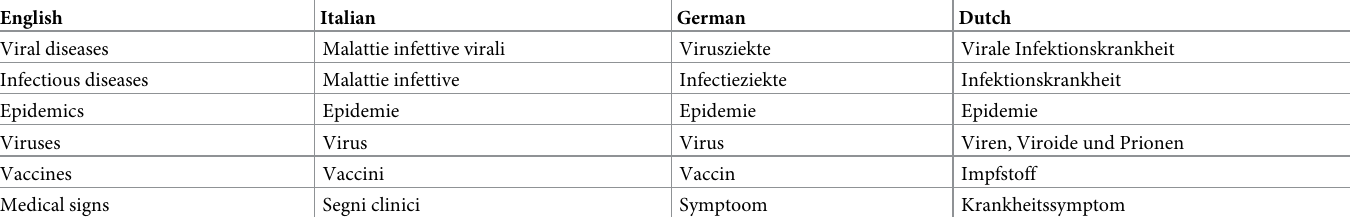
Table 1. Selected Wikipedia categories. We first selected the Italian categories, and then we chose the corresponding German and Dutch translations. We report the English categories for